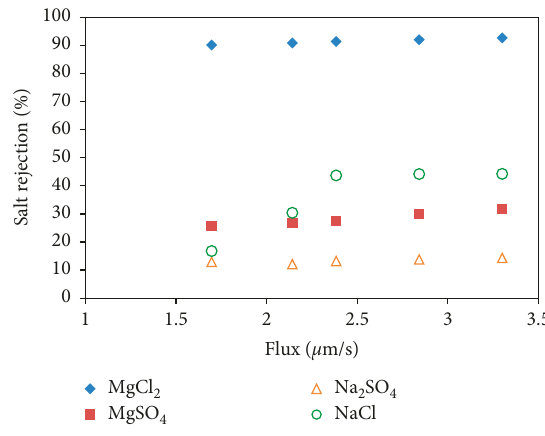
Figure 7: Effect of the operating pressure on the rejection per- formance of the MWCNT/CHIT evaporative cast